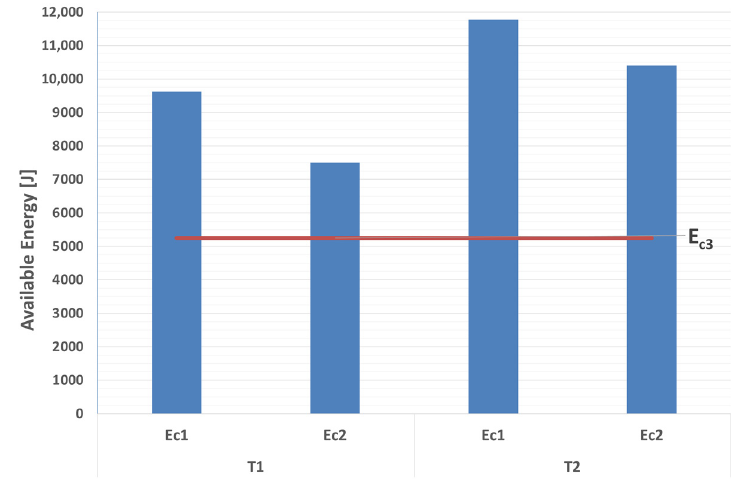
Figure 12. Energy values E C1 , E C2 , E C3 for T1 and T2 configurations.